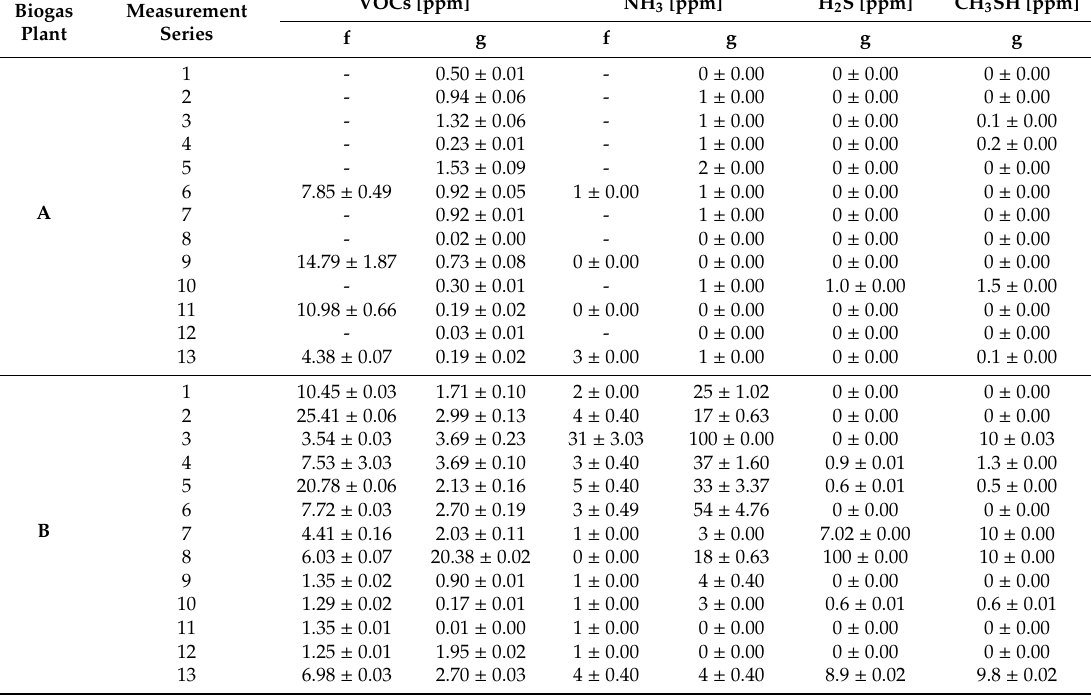
Table 5. Measurement results for the fermentation preparation technological operation. Biogas